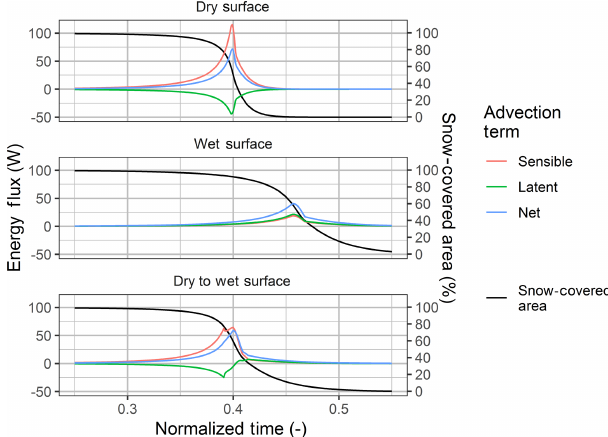
Figure 9. Latent heat (green), sensible heat (red) and net (blue) ad- vection components for the SLHAM scenarios plotted with snow- covered area